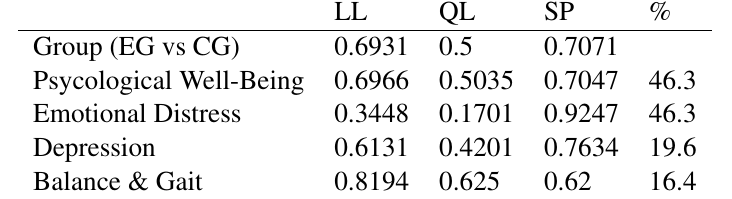
Table 4 Bayesian network’s validation and percentage of mutual information between Group and the rest of the